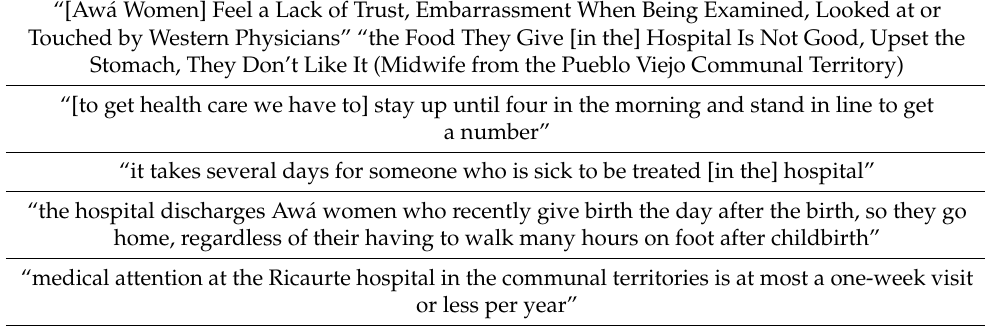
Table 2. Testimonies from participants about institutional health care and the